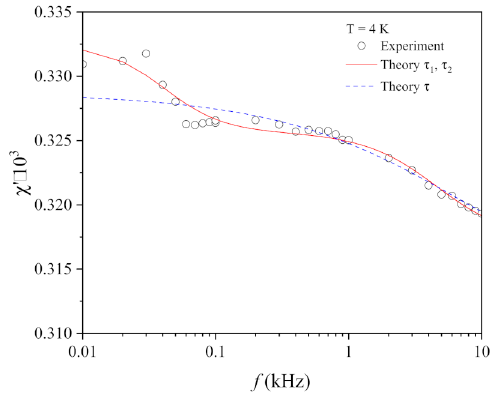
Figure 9. Results of the fitting of the frequency dependency of dynamic AC susceptibility for the nanocomposite with the ytterbium